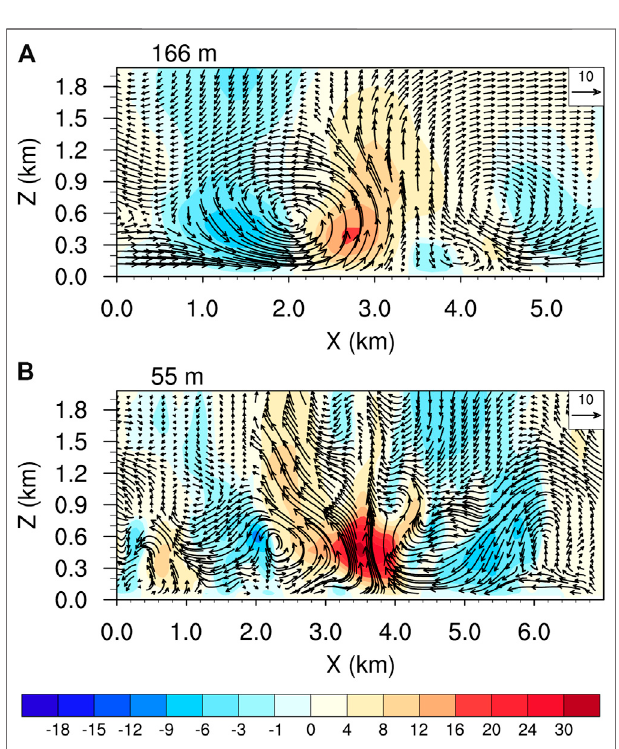
FIGURE 11 | Vertical cross sections of vertical velocity (shaded, m s − 1 ) and the perturbation winds (vectors, m s − 1 ) along the line segment in Figure 10 from the grid spacings of (A) 166 m and (B) 55 m, respectively.